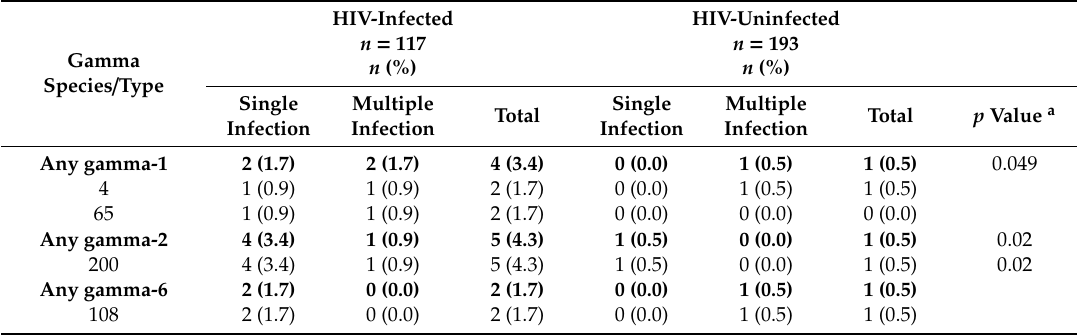
Table 4. Species-specific and type-specific prevalence of gamma HPVs in single and multiple oral infections among the 310 MSM of the OHMAR study according to HIV